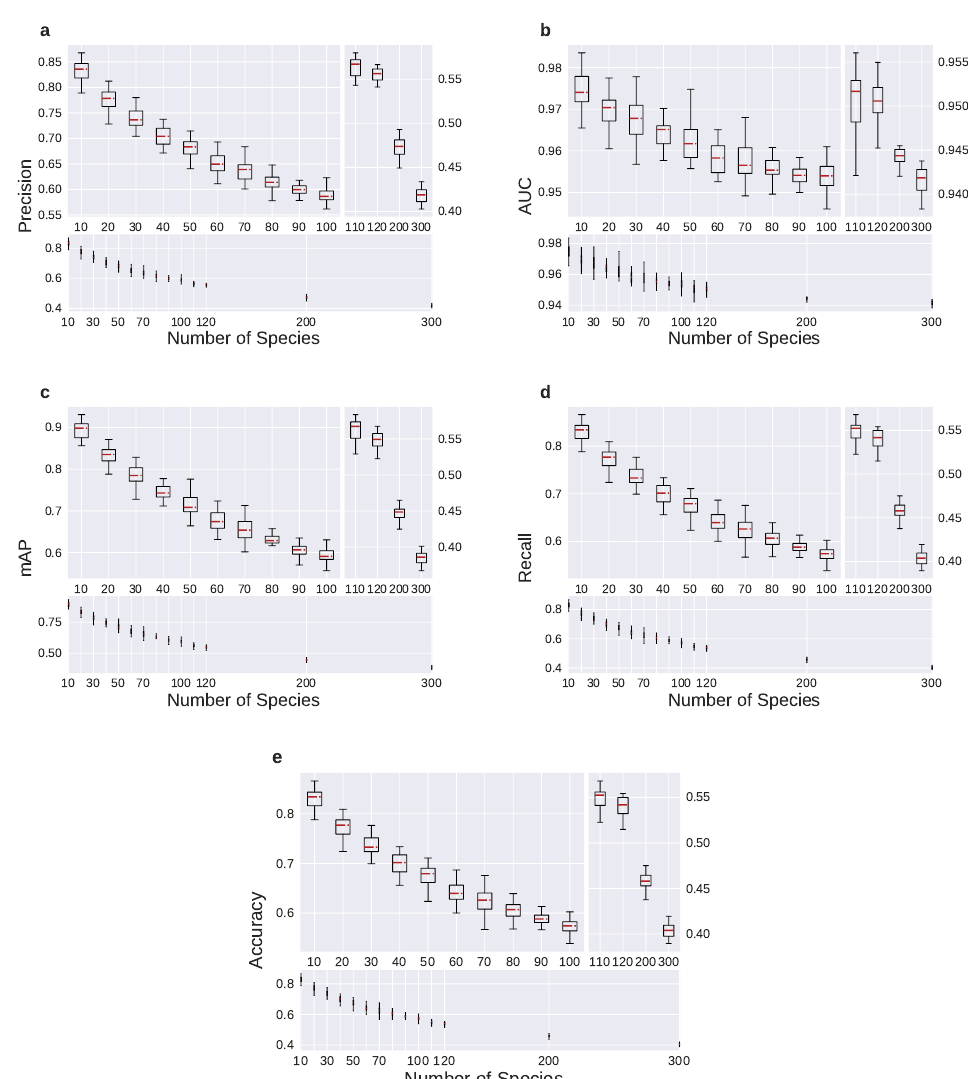
Figure 3. The performance measures ( a ) Precision ( b ) AUC ( c ) mAP ( d ) Recall and ( e ) Accuracy decrease as the number of species in each subset is varied between n = 10 and n = 300. Shown are the ranges from best result to worst result (whiskers) obtained for 20 different randomly drawn subsets for each value of n . The red marking in each box represents the median, and the boxes indicate the middle 50% of the